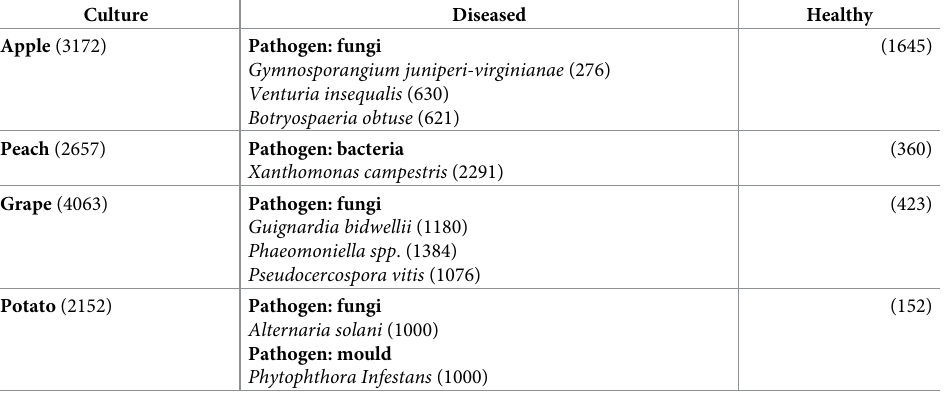
Table 2. List of crops and their disease status used in the